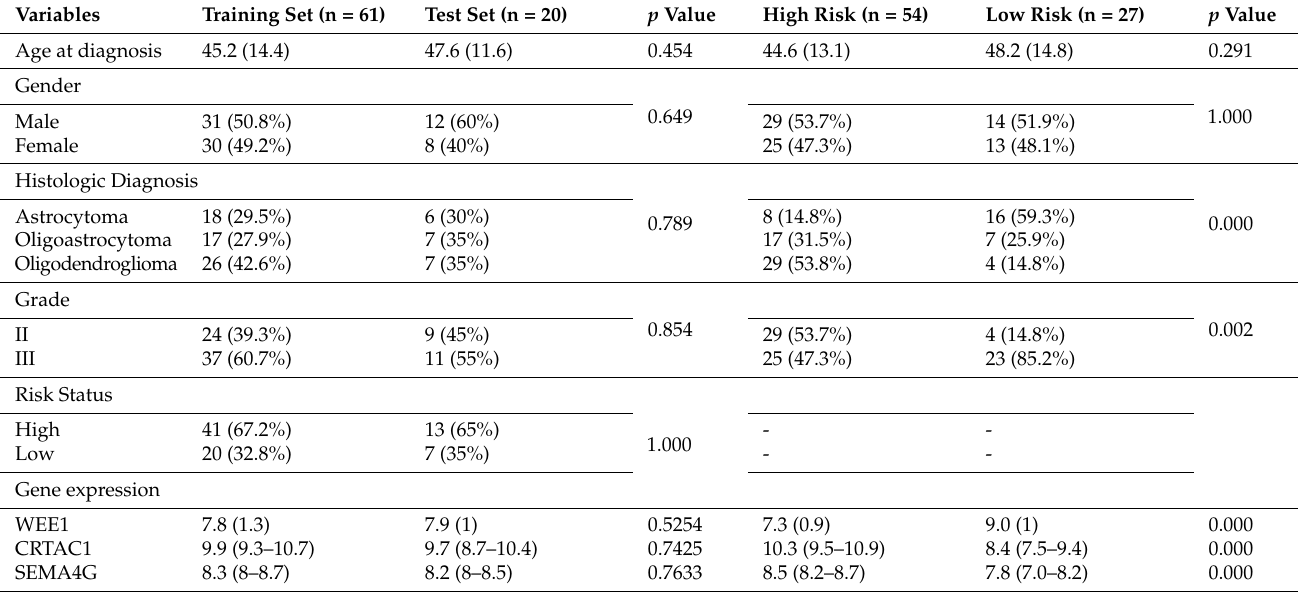
Table 1. Patient